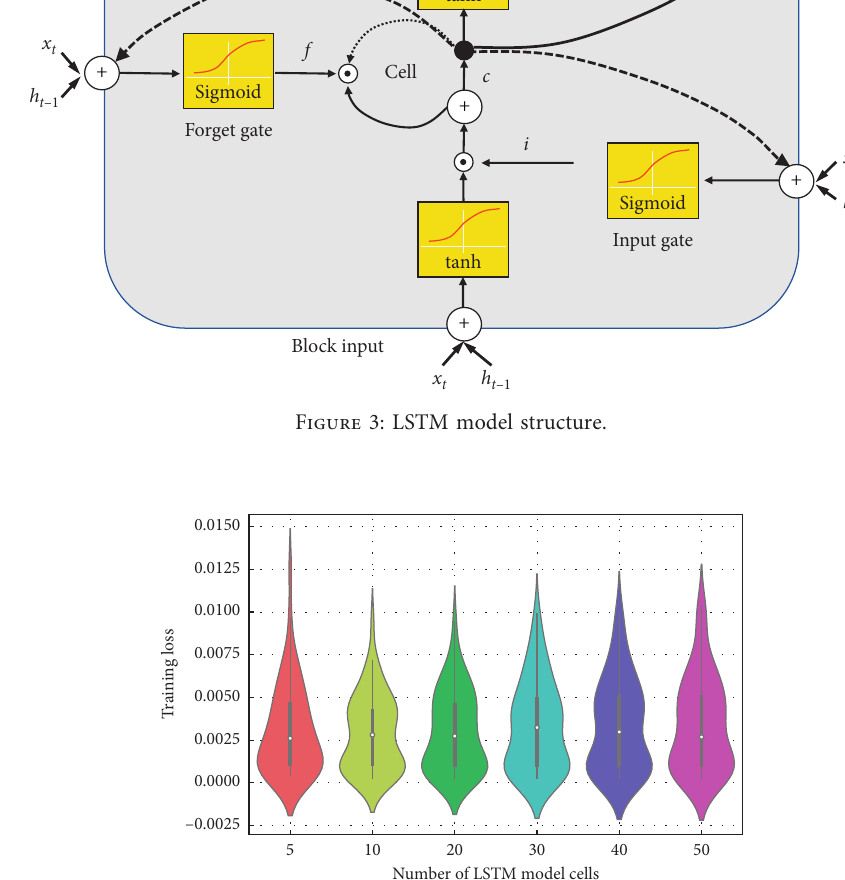
Figure 4: Training loss LSTM model with different number of units.